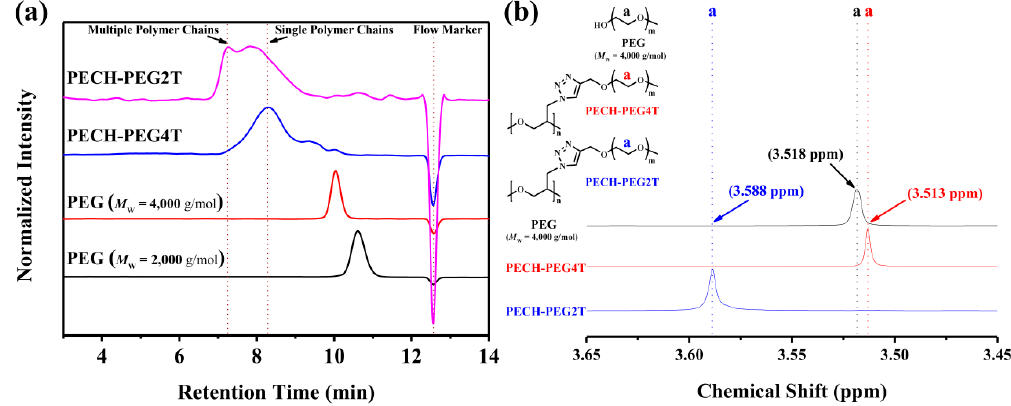
Figure 3. ( a ) Gel permeation chromatography (GPC) traces for PECH ‐ PEG4T, PECH ‐ PEG2T and commercial PEG polymers with water as the eluent at 50 °C. ( b ) 1 H NMR spectra of PECH ‐ PEG4T, PECH ‐ PEG2T and PEG ( M w = 4000 g/mol) in D 2 O at 25 °C.